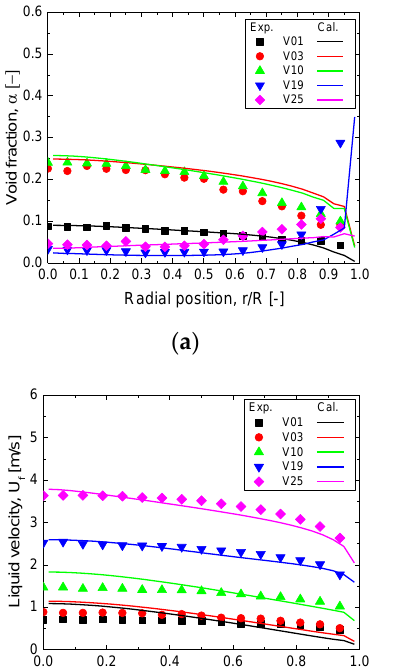
Figure 7. Comparison of the predicted two-phase parameters with the Kalkach-Navarro experiment: ( a ) void fraction (Cases 1–4), ( b ) void fraction (Cases 5–8), ( c ) bubble diameter (Cases 1–4), and ( d ) bubble diameter (Cases 5–8).